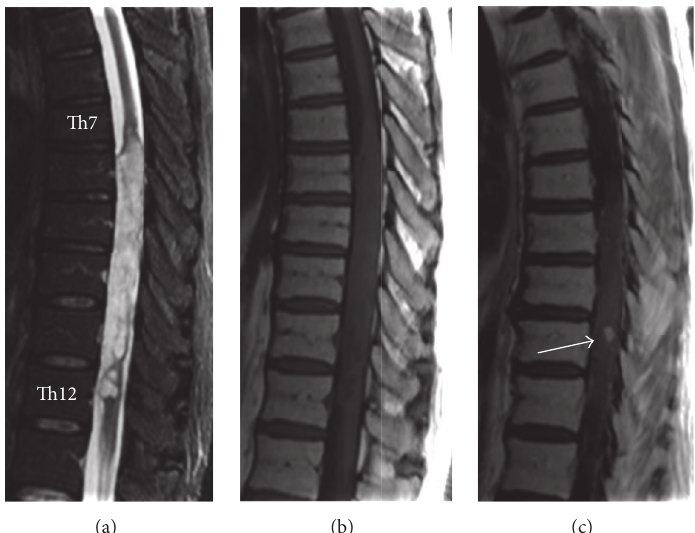
Figure 1: (a) Sagittal T2W1 showing cord expansion and hyperintense signal extending from the Th7 level to Th12 level surrounding both anterior and posterior aspects of cord. (b) Sagittal T1W1 showing an isointense mass with no clear-cut demarcation between cord and tumor. (c) Gadolinium contrast-enhanced MRI reveals slight enhancement. This is only a part of the tumor.